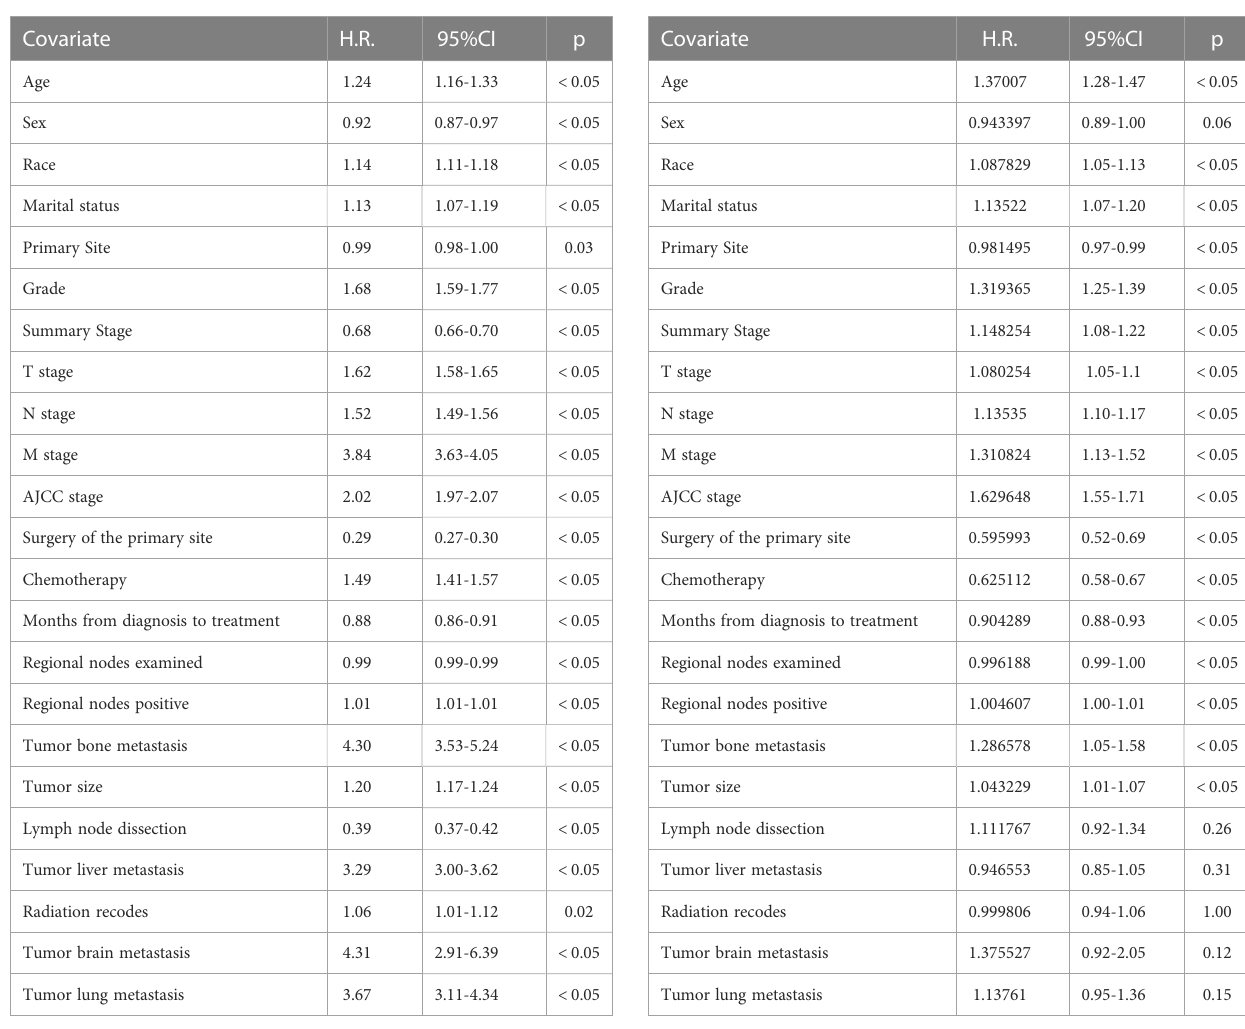
TABLE 2 Univariate CPH analysis. TABLE 3 Multivariate CPH